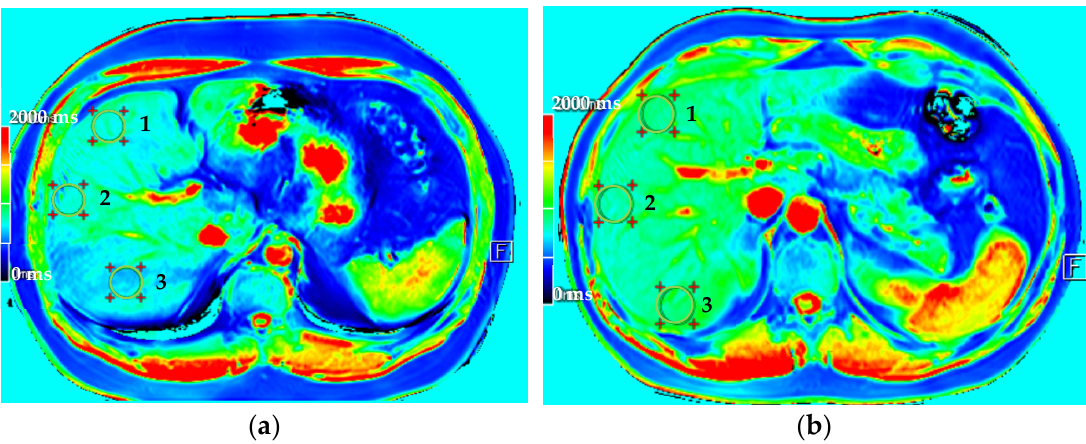
Figure 4. T1 maps of patient #1 ( a ) and patient #2 ( b ) acquired at 3T. There are 3 ROIs in the liver following Couinaud’s segments IV (1), VIII (2) and VII (3).